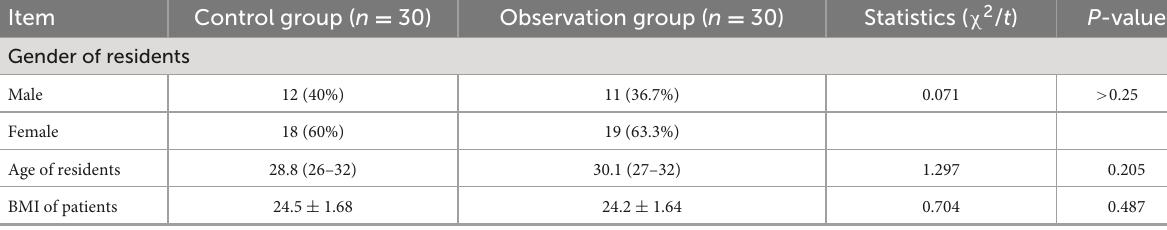
TABLE 1 General data of resident doctors and patients in two groups.